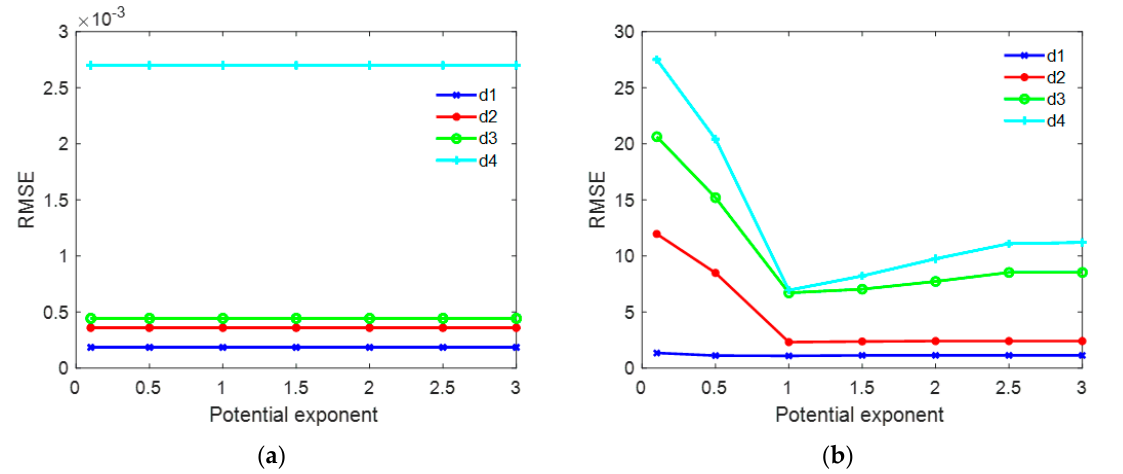
Figure 10. ( a ) RMSE curves of TSPA-PUMA of Figure 9f–i with different potential exponents between 0.1 and 3 with an increment of 0.5. ( b ) RMSE curves of TSPA-PUMA of Figure 9j–m with different potential exponents between 0.1 and 3 with an increment of 0.5.